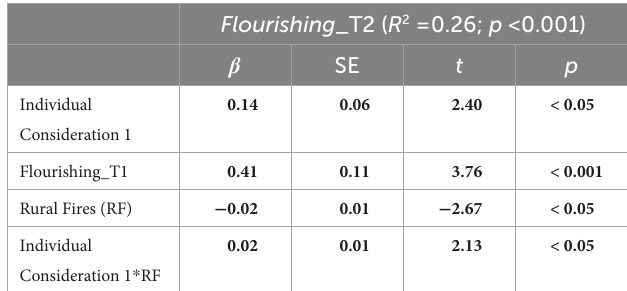
TABLE 5 Analysis of the effect and moderation between the variables under study—individual consideration dimension.